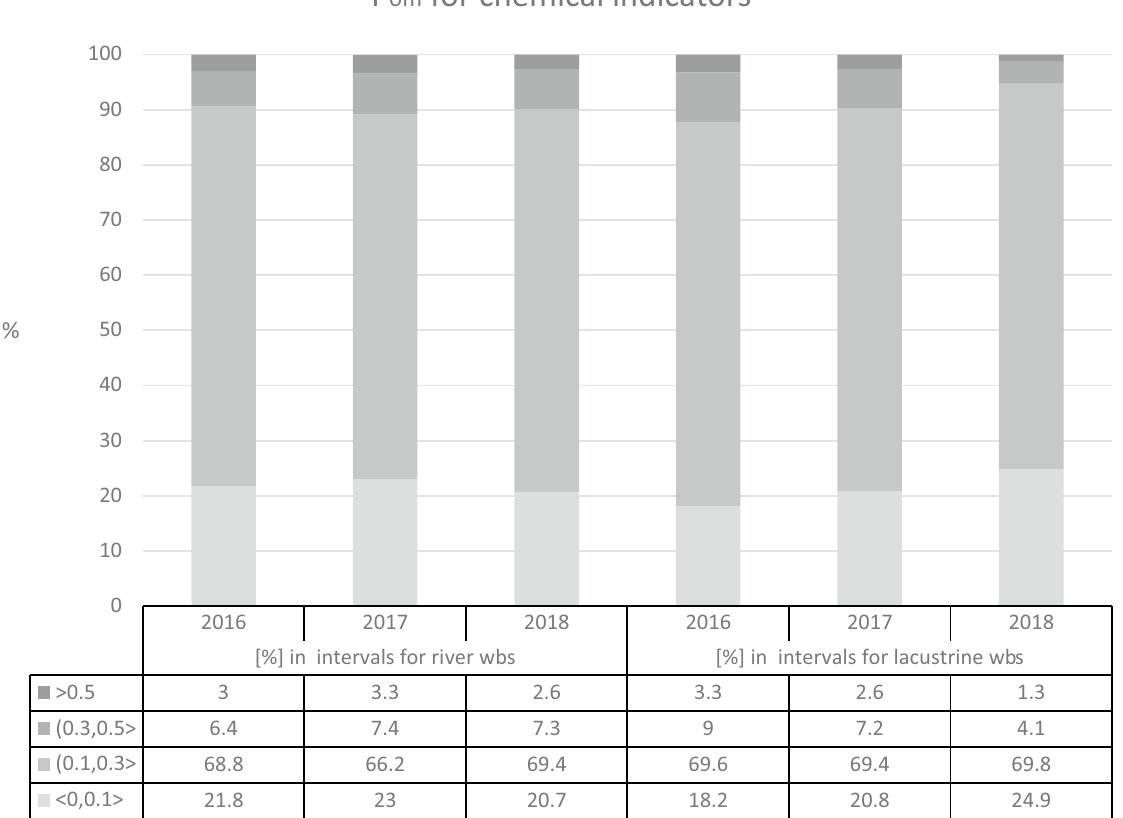
Table 3. The results for all years are lumped together but presented separately for good and below good status. The two main columns on the left of Table 3 display values of P om resulting from conventional and modified approach to st. dev. for censored data. Chemical substances, on the basis of which below good status was assessed, occurred in waters in concentrations much higher than LOQ. This is the reason that assessment of P om values for wbs in below good chemical status was not affected by the method of calculation of st. dev. and that is why there are single columns for both types of wbs in below good status in Table 3. Similarly to the way of presenting P om for indicators, P om values for chemical status were discretized into four intervals depending on the P om value. There are differences in percentage in the first three intervals in the columns for good chemical status but the